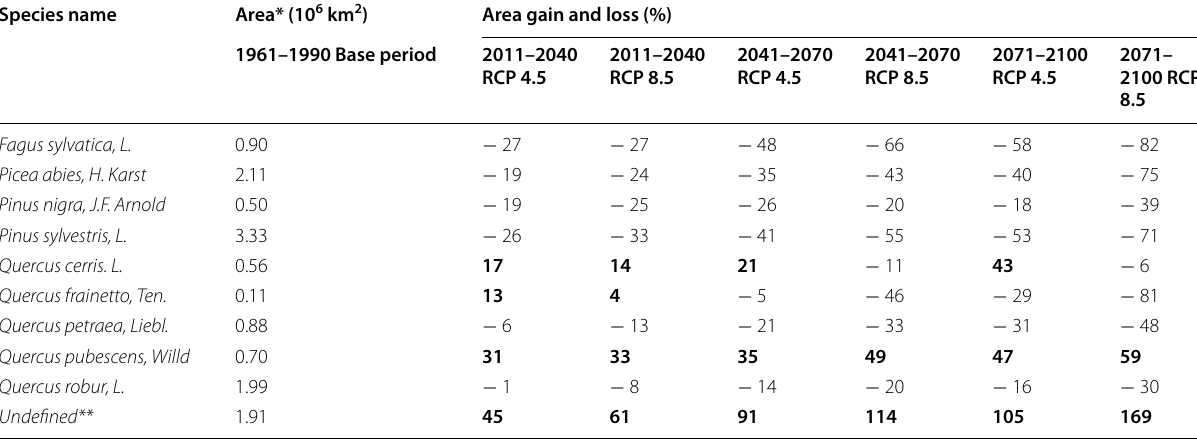
Area gains are in bold Tables with country-by-country estimates can be found in Illés and Móricz 2022–Species_area_by_country.xls) *Area derived from the referenced occurrence data and climatic databases. It is not intended to represent the total area that is currently occupied by the species **Areas with climatic characteristics that are outside the predictable range